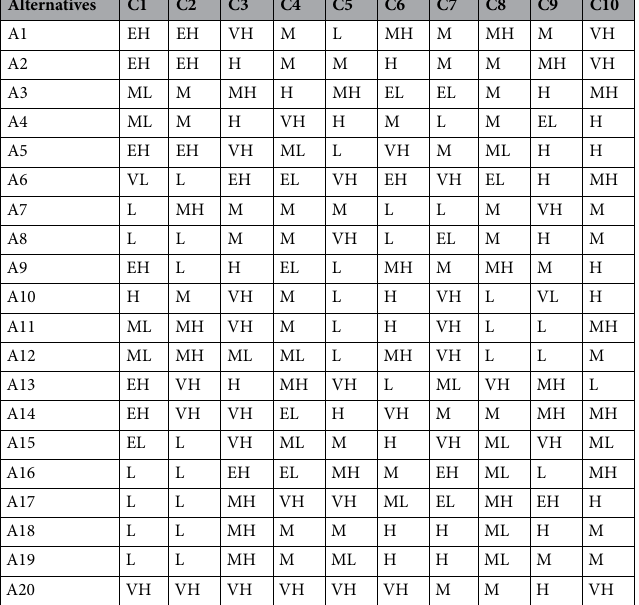
Table 5. Performance of alternatives according to the decision-maker.